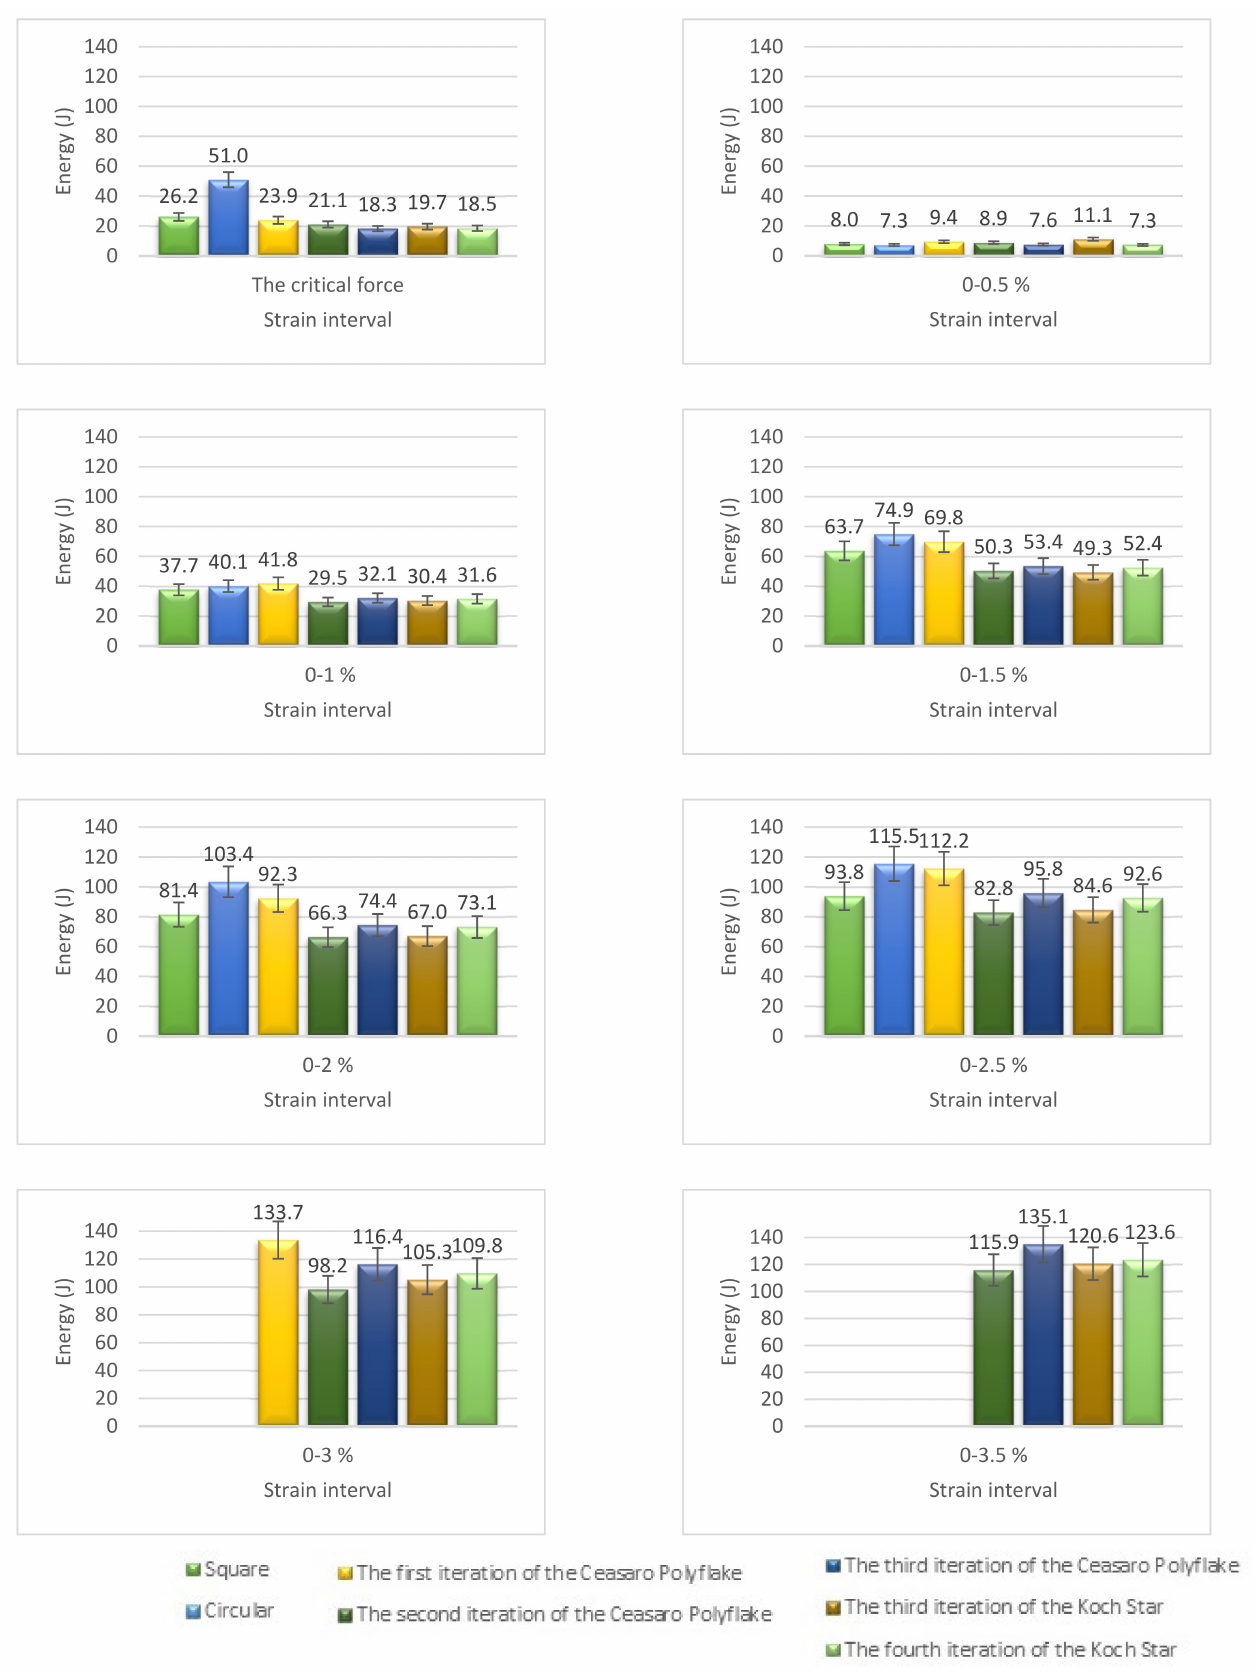
Figure 9. The energy needed to achieve a particular strain of tested concrete–plastic